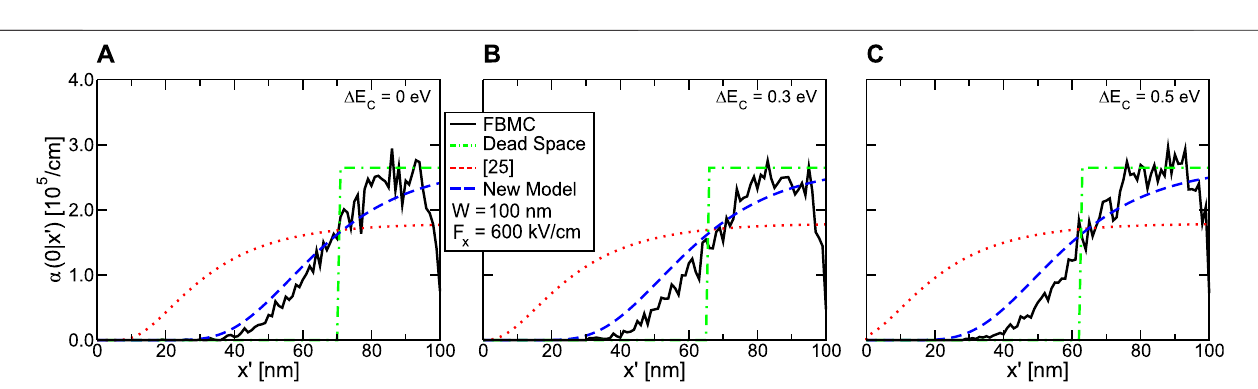
FIGURE8| α ( x , x ′ )pro fi lesasinFig.7butforaGaAsregion(100 nmofwidth)followingenergystepsofdifferentamplitude Δ E C .Auniformelectric fi eld F x =600 kV/ cm is present in the GaAs region.